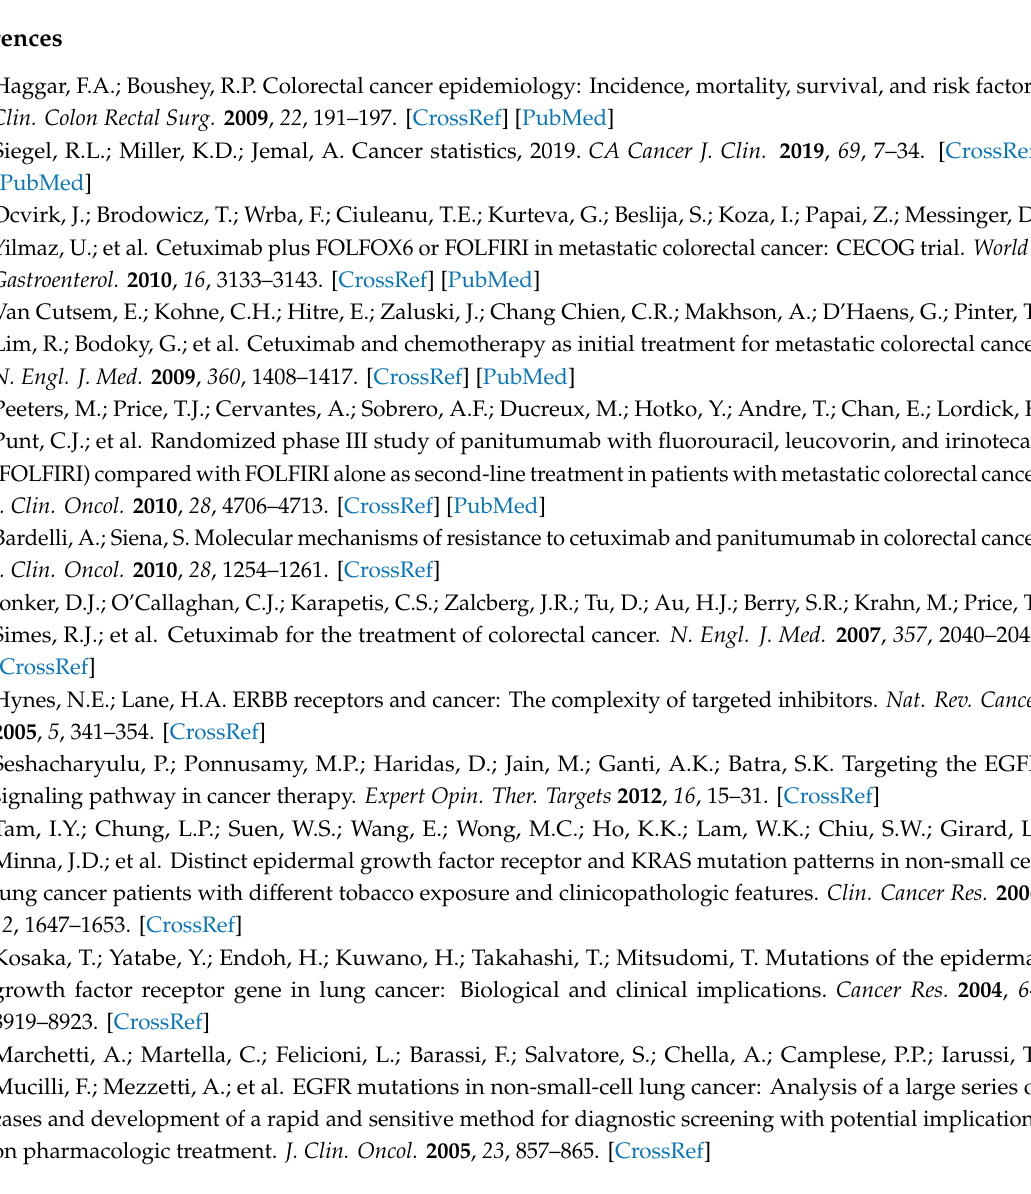
Figure S1: TNS4 is significantly downregulated by cetuximab in a subset of colon cancer cell lines, Figure S2: TNS4 overexpression in LS174T cells decreased the e ffi cacy of EGFR and MEK